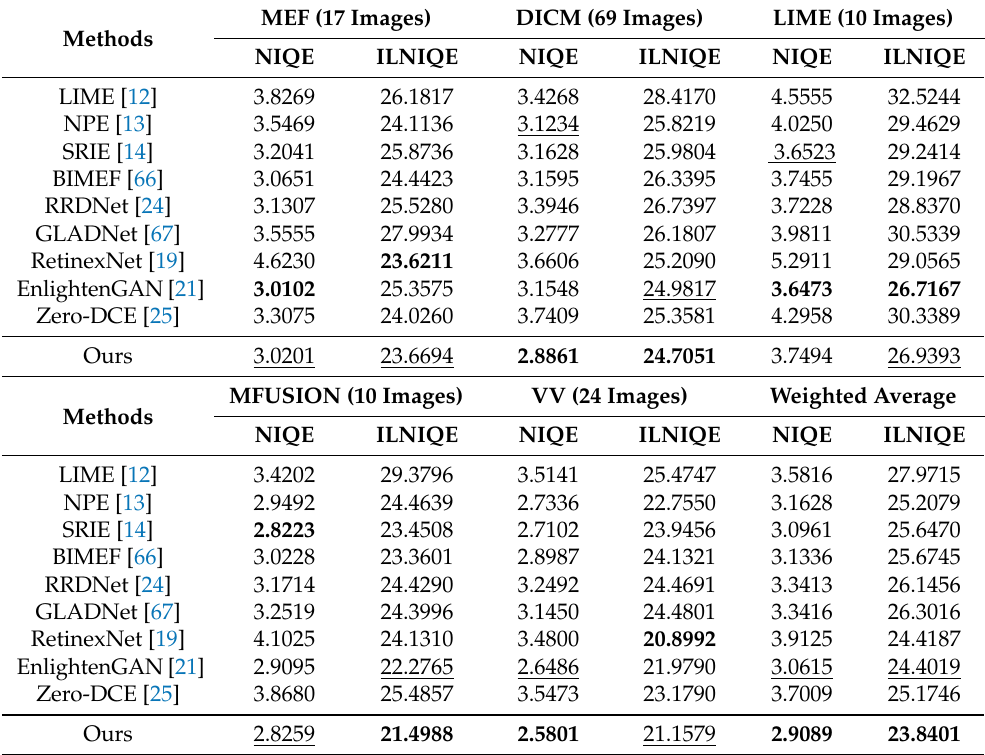
Table 2. Quantitative comparison between our method and other state-of-the-art methods on 5 real- world datasets. The best results are highlighted in boldface, while the second results are